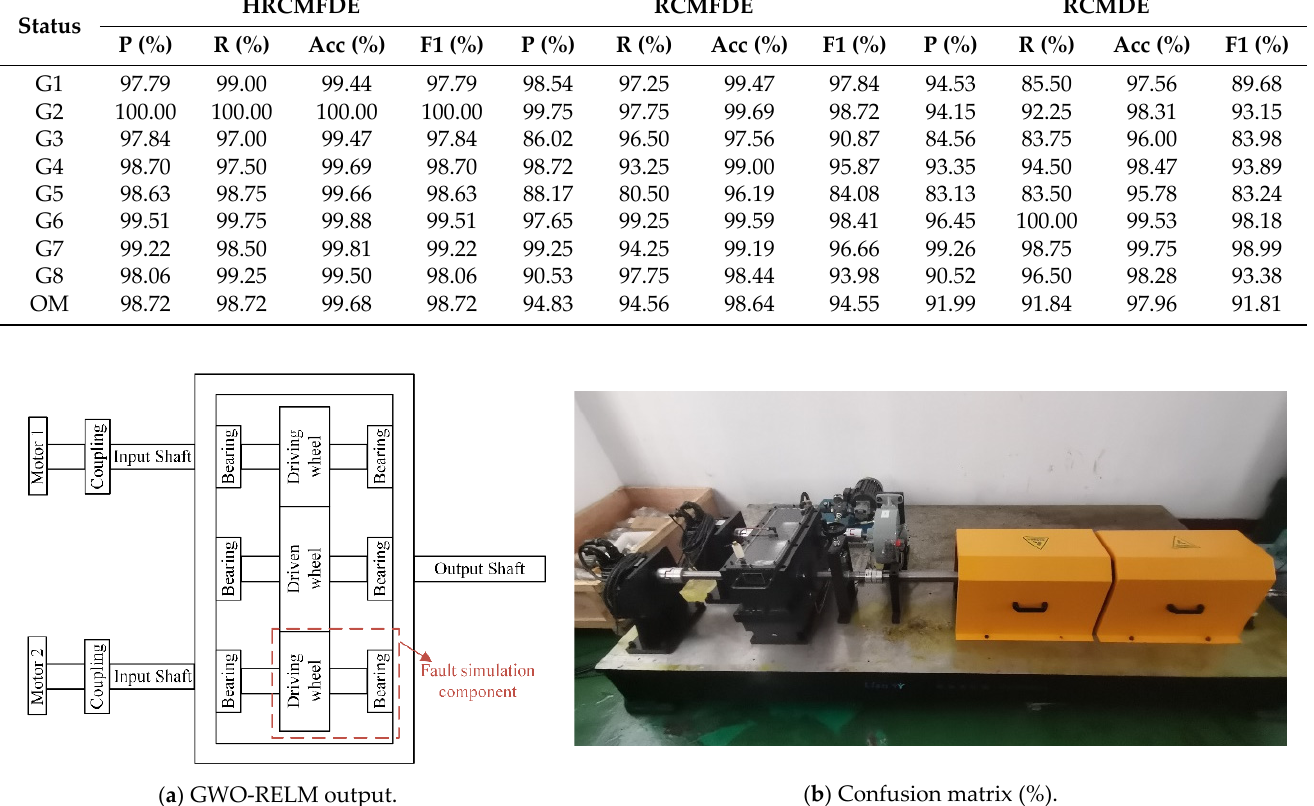
Figure 15. The experimental platform and gearbox structure.